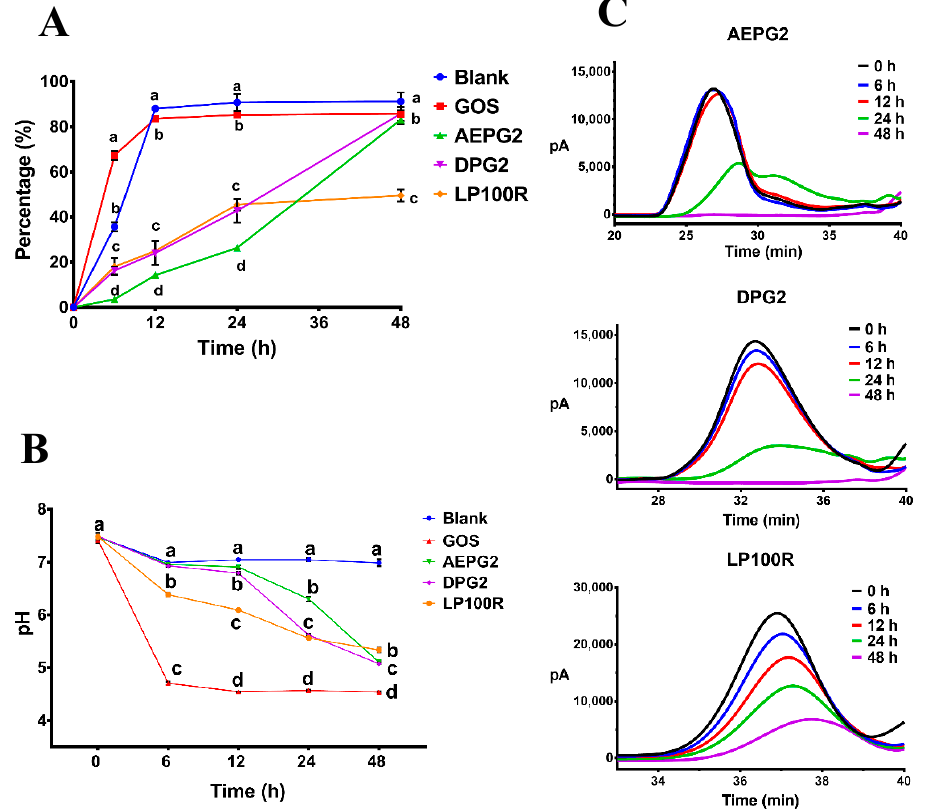
Figure 3. Consumptions of carbohydrates ( A ), changes in pH ( B ), and HPGPC chromatograms of PGPs ( C ) in fermentation broth at different time points of fermentation in vitro. Different lowercase letters indicate significant differences ( p < 0.05) among different samples at the same time. n = 3.